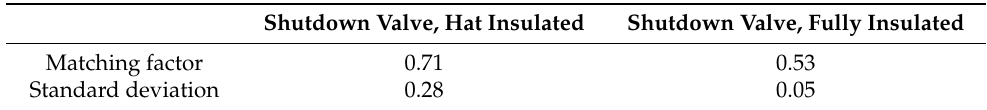
Table 1. Calculated matching factors for the two valve types with their standard deviations; data for hat insulation are from previous tests [10].